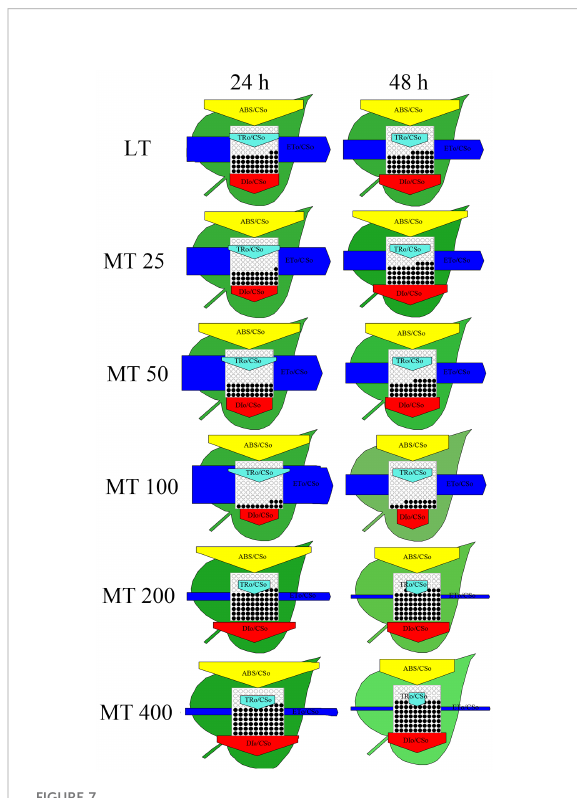
FIGURE 7 The energy fl ux models (leaf models) of low temperature- stressed cucumber plants pre-treated with different concentrations of melatonin